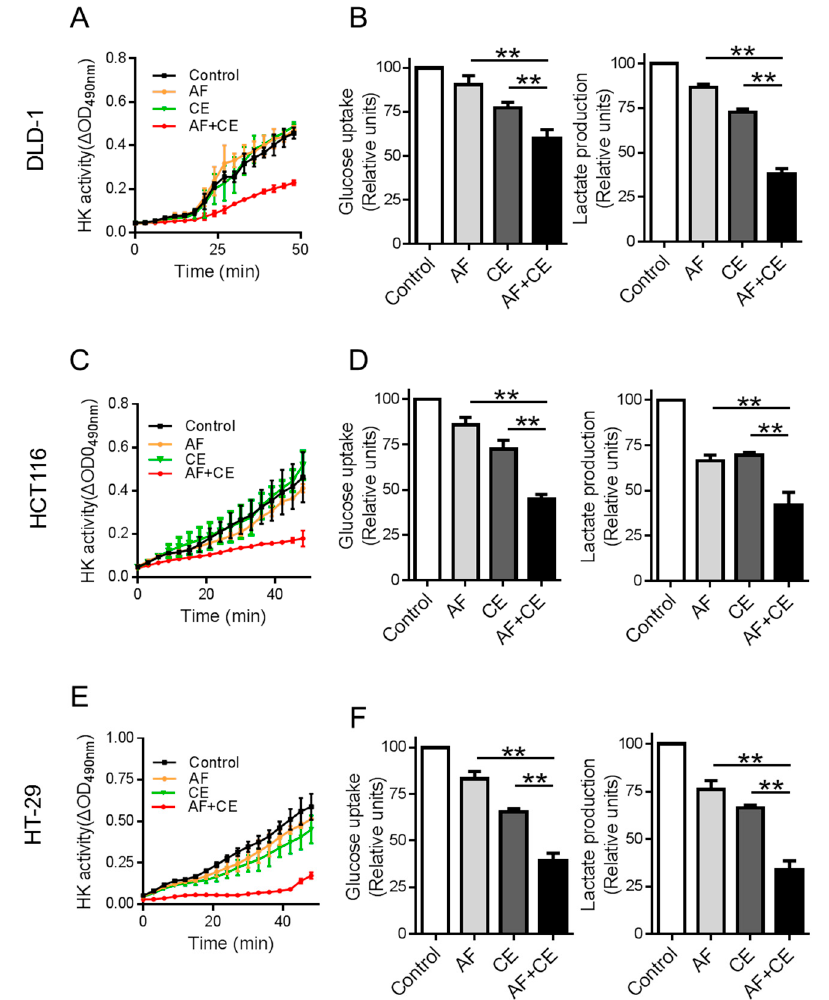
Figure 4. AF/CE combination suppressed glycolysis through hexokinase (HK) inhibition. ( A , C , E ) Curves of hexokinase activity in cells treated with indicated conditions. Cells were incubated with AF 1 μ M, CE 10 μ M, and AF 1 μ M + CE 10 μ M for 24 h, and protein extracts were used to analysis of hexokinase activity. ( B , D , F ) Inhibition of glucose uptake and lactate production by AF 1 µ M, CE 10 µ M, and AF 1 µ M + CE 10 µ M in indicated cells. Three cell lines were treated with the indicated conditions of AF and CE in fresh medium for 24 h. The culture media from each sample was then collected for analysis of glucose and lactate. Each bar represents mean ± SD of three separate measurements, ** p < 0.01.